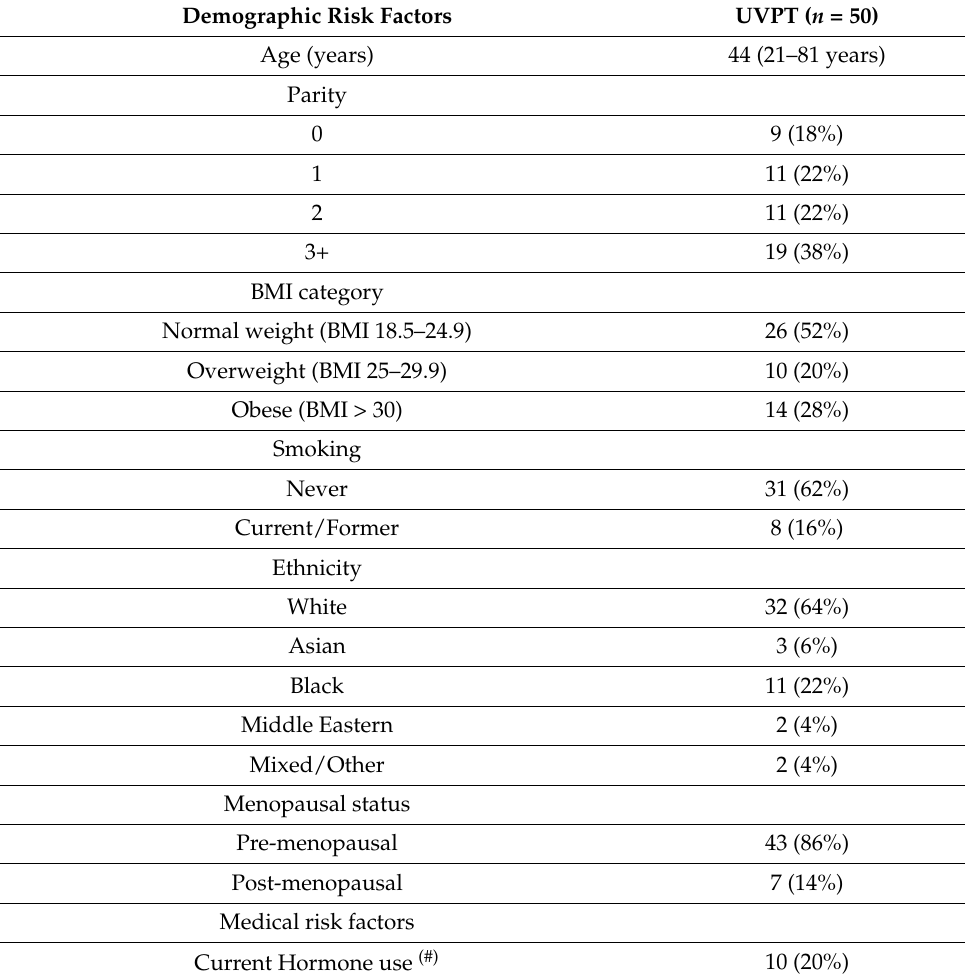
Table 1. Patient characteristics, medical, and ultrasound risk factors in the UVPT